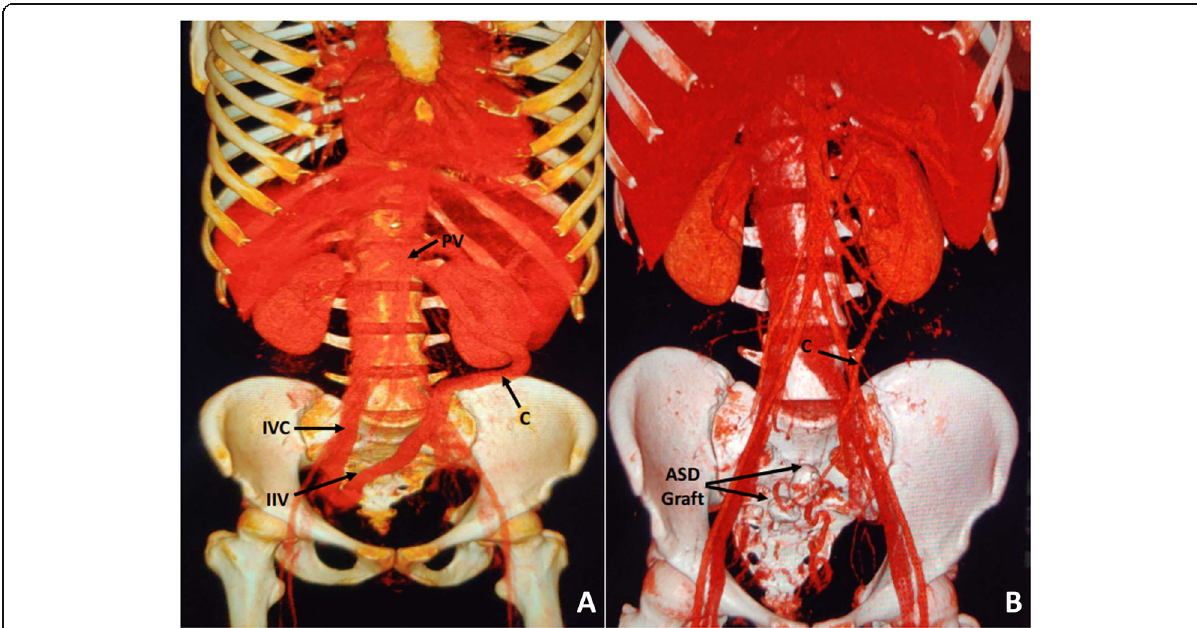
Fig. 2 3D reconstruction CT images illustrating the shunt before and after closure. A Before closure, the shunt was dilated and tortuous (C, venous collateral between right internal iliac vein and superior mesenteric vein; PV, portal vein; IVC, inferior vena cava; and IIV, internal iliac vein). B After closure, the shunt had shrunken significantly (shunt closure with ASD Cocoon stent graft, and C – shrunken